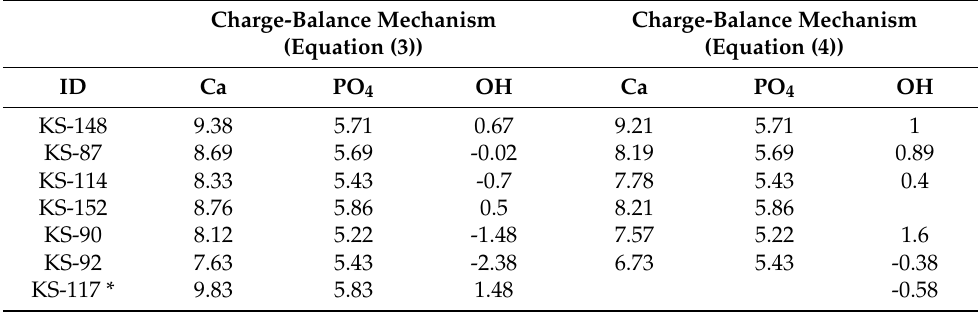
Table 6. Theoretical mole amounts of Ca, PO 4 , and OH in products after estimation of substitution consequences of carbonate using IR/NMR data and Equations (1) and (2), and europium substitution mechanism based on Equation (3) or Equation